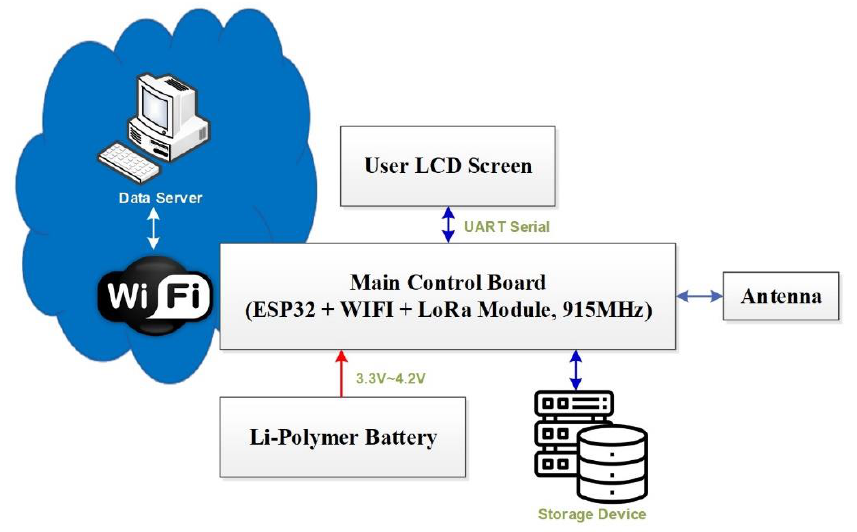
Figure 3. The configuration of the RX module for monitoring the PV junction box.